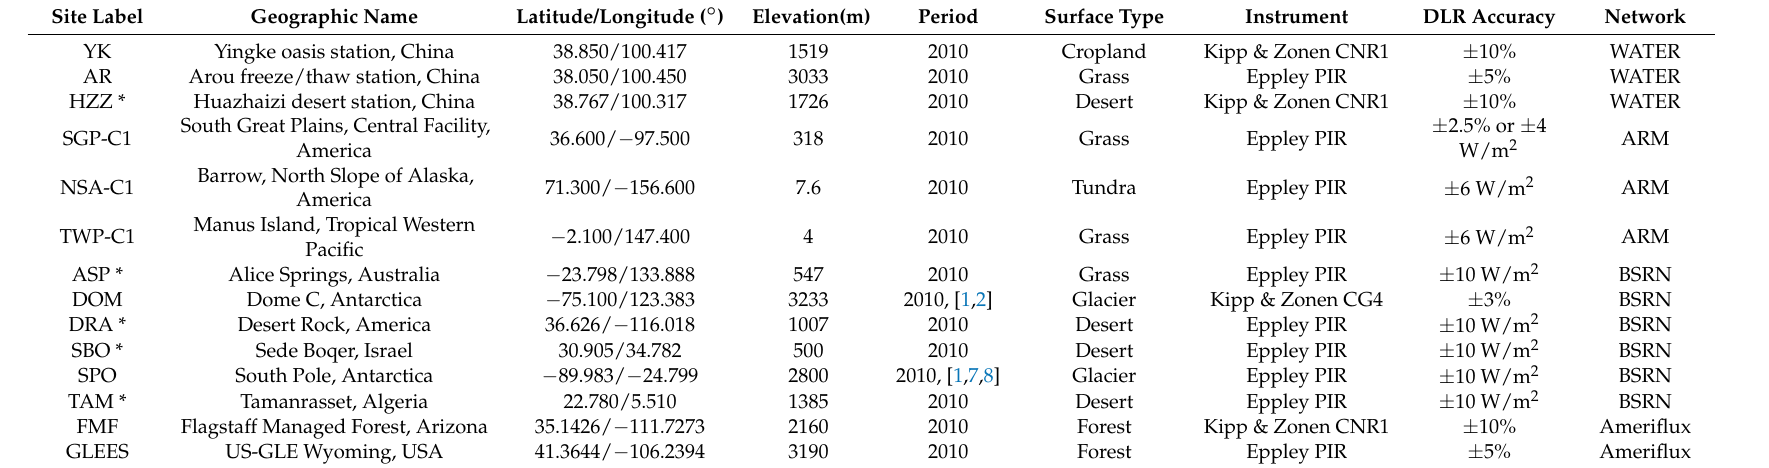
Table 6. Description of site conditions. Sites used as examples of dry-arid regions are marked with